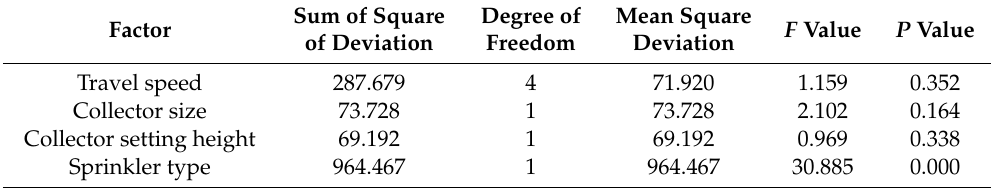
Table 6. Analysis of variance results for the e ff ect of various factors on D w . Sum of Square Factor of